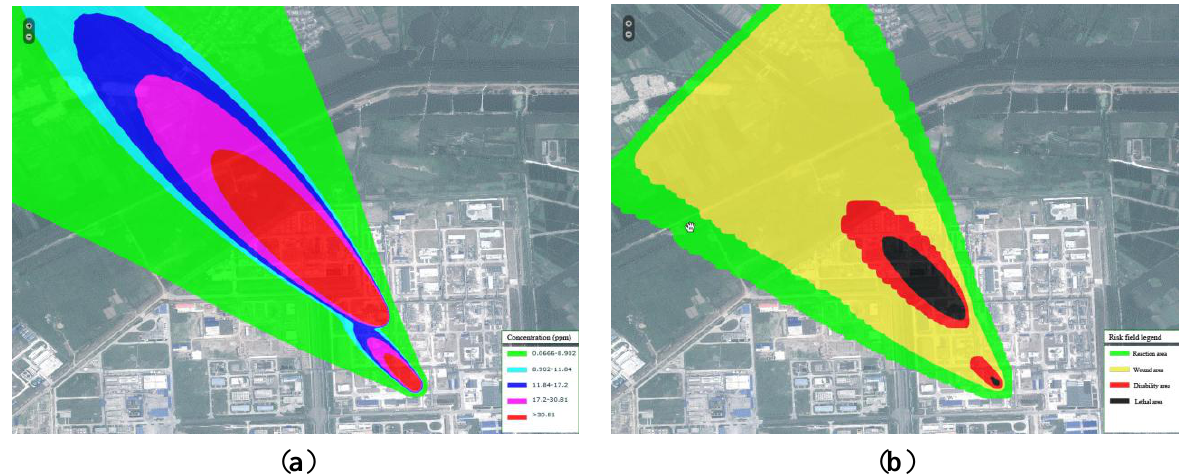
Figure 6. Gas-liquid H S leakage. Image ( a ) shows the concentration field and image ( b ) 2 shows the risk field.